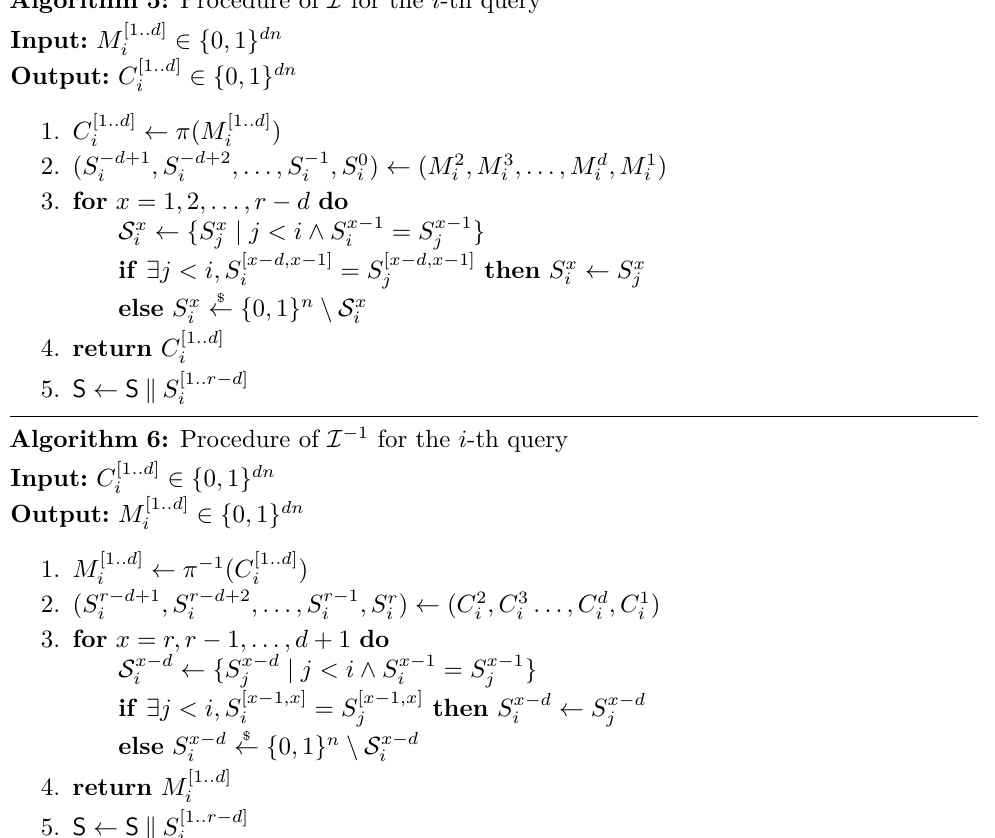
Algorithm 5: Procedure of I for the i -th query